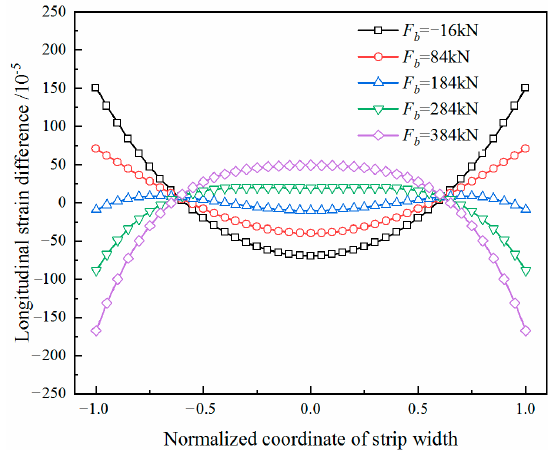
Figure 11. Longitudinal strain difference with different bending forces.